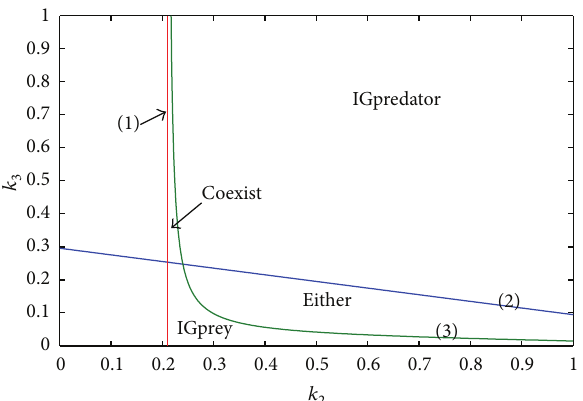
Figure 1: Regions of potential coexistence for the local reactive kinetic of (2a)–(2c). In the region labeled “IGprey” (on the right side of the line marked “(1)” and below the line marked “(3)”), the IGprey extirpates the IGpredator, whereas in the region labeled “IGpredator” (in the right of the line marked “(1)” and above the line marked “(2)”), the IGpredator extirpates the IGprey. Region labeled “either” is that in which coexistence is not possible, but the species that persists depends on initial conditions. Region labeled “Coexist” is the intersection of the regions labeled “IGprey” and “IGpredator.” Parameter values were chosen to be system appropriate: 𝜅 1 = 0.7, 𝛼 = 2, ℎ = 0.5, 𝑒 1 = 0.1 , and 𝑒 2 = 0.21